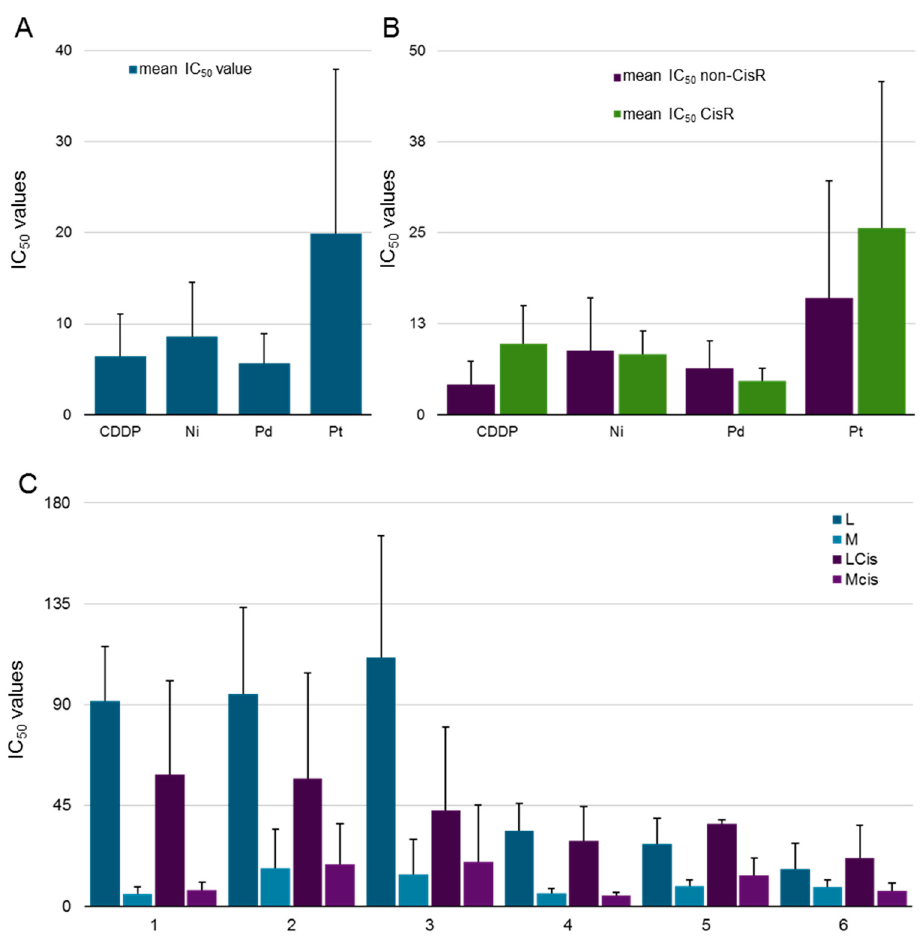
Figure 4. ( A ): Comparison for mean IC 50 value (on all five cell lines) for different metals (M1–6) and cisplatin (CDDP), showing Pd complexes to be the most active molecules in general. ( B ): Mean IC 50 values for sensitive and resistant ovarian cancer cell lines SKOV3 and A2780, showing promising results for Pd and Ni complexes. ( C ): Comparison of β -hydroxydithiocinnamic acid esters and their corresponding metal complexes on ovarian cancer cell lines. All values in [µM]. Table 5. IC 50 values [µM] on non-cancerous cell lines’ keratinocytes, fibroblasts and MCF10A for most active compounds of each metal class, Ni1, Pd3, Pt4, and their reference cisplatin. Cell line